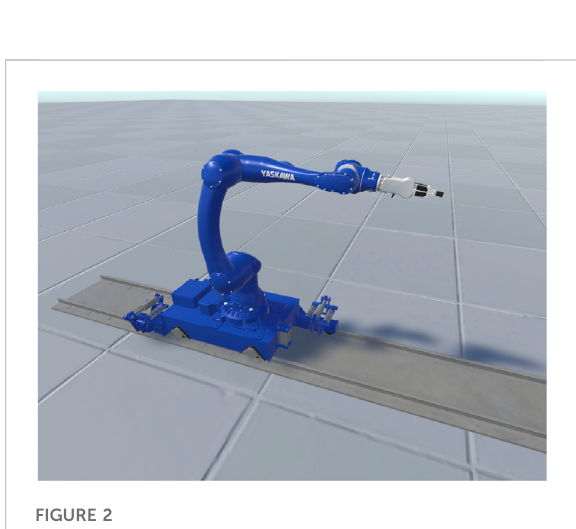
FIGURE 2 Robot digital twin model in virtual reality